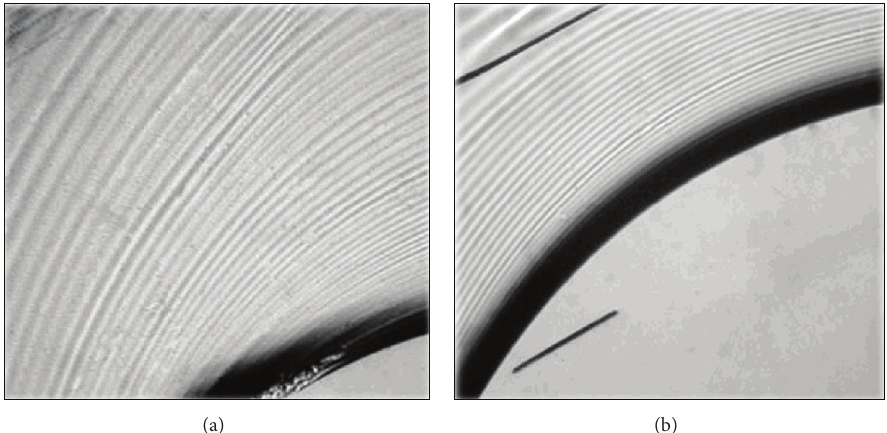
Figure 13: Consecutive stages (a) and (b) of structuring in the strong flow of a homogeneous polymer melt. The distance between lines is 1mm.